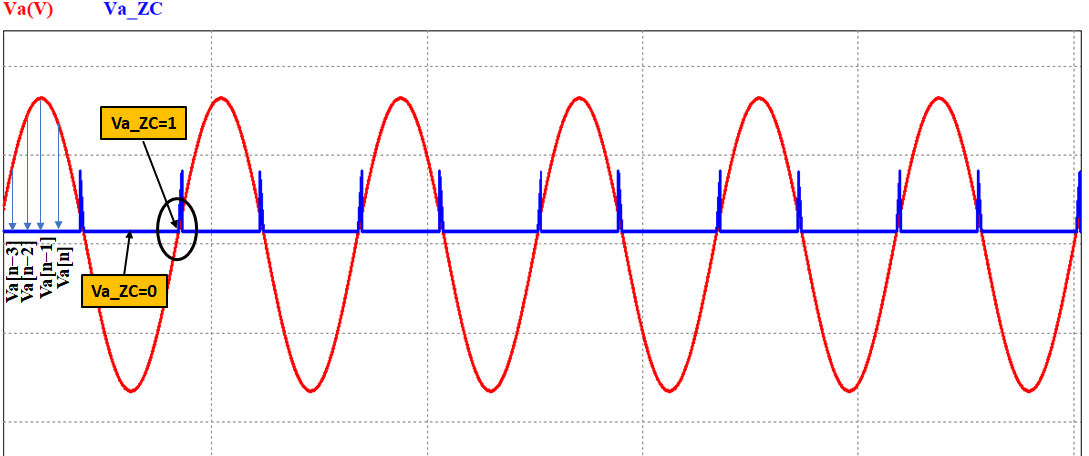
Figure 6. Zero-voltage crossing detection signal generation (Va_ZC) of any AC voltage pure sine waveform (Va).